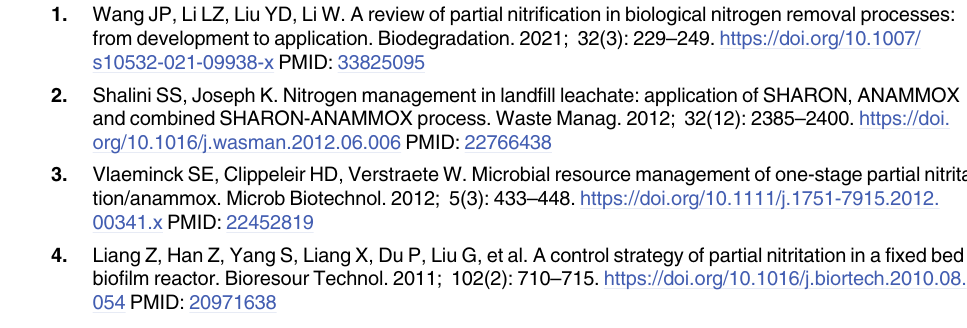
S1 Fig. Schematic diagram of the SBR. 1: reaction tank; 2: storage tank; 3: pump; 4: blower; 5: air diffuser; 6: flow meter; 7: time-delay device; 8: influent; 9: effluent. (TIF) S2 Fig. The rarefaction curve of all samples. S3 Fig. Principal component analysis (PCA) based on Illumina sequencing data. (TIF) S1 Table. The PCR primer sequences and targets in this study. S2 Table. Numbers of sequences and OTUs. S3 Table. The specific growth rates of AOB and